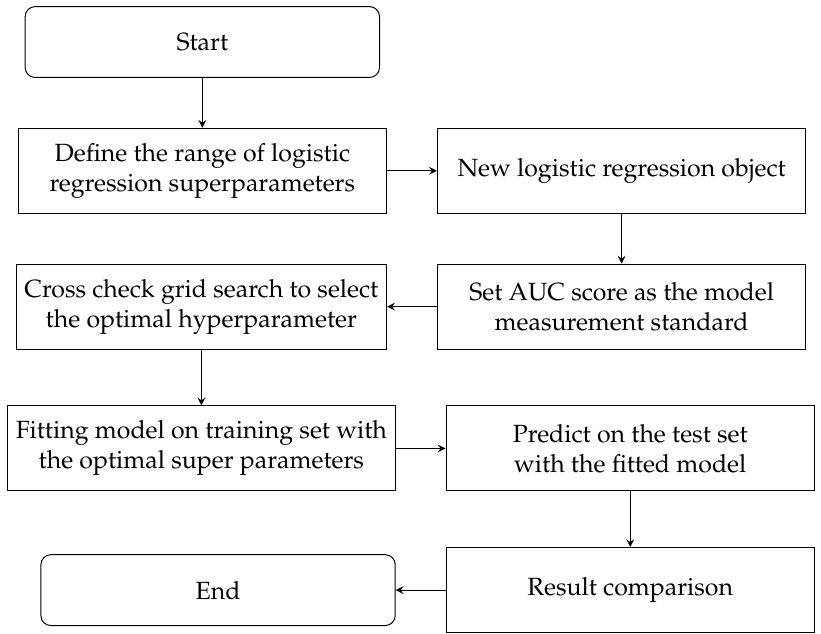
Figure 2. Logistic Regression model prediction